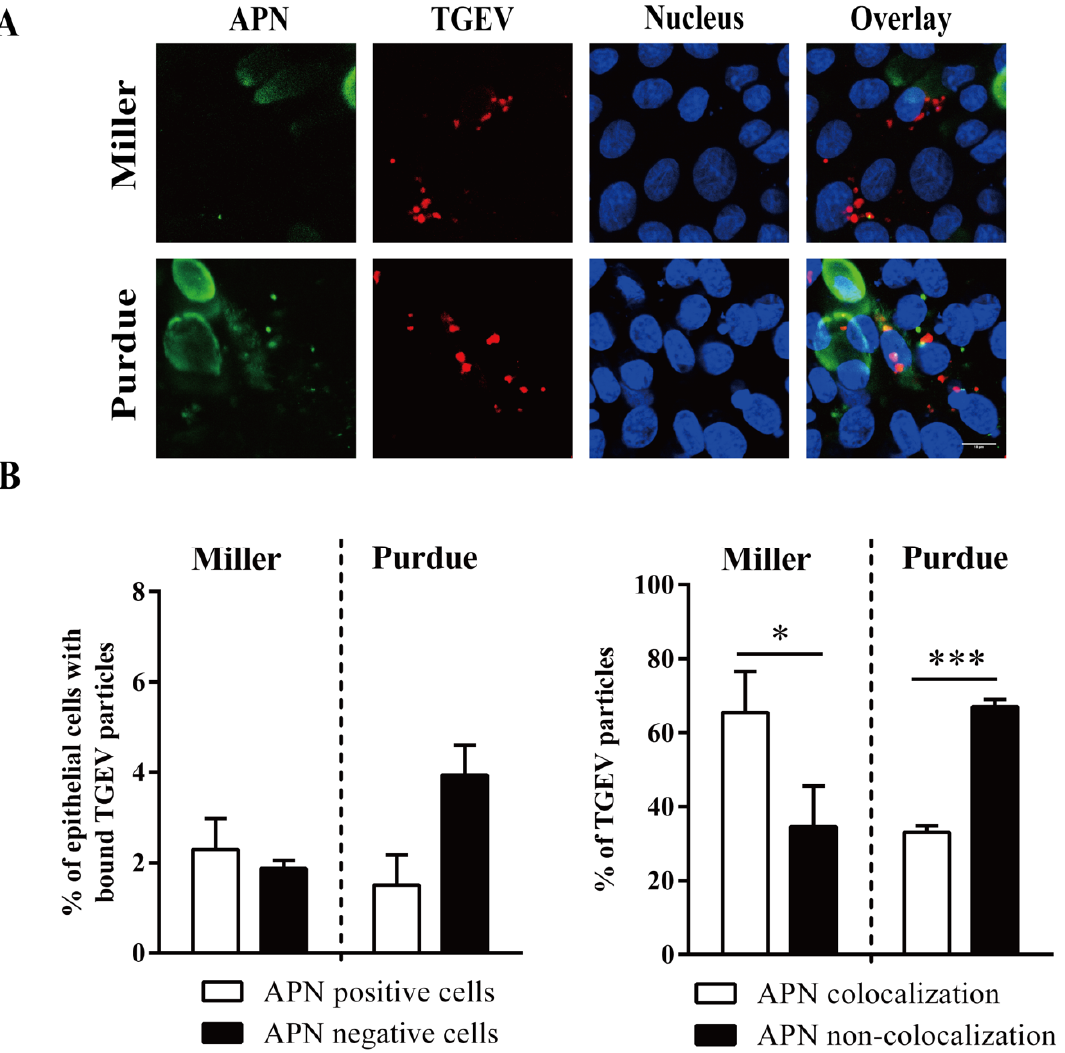
Figure 7. TGEV binds to APN positive/negative enterocytes. Primary enterocytes were inoculated at 4 °C with TGEV particles (m.o.i. = 10). ( A ) Double immunofluorescence staining of TGEV particles bound to APN positive/negative cells. Scale bar: 10 µm. ( B ) The percentage of cells with bound virus particles (left panel). The percentage of APN colocalized TGEV particles was counted based on five random fields (right panel). Data are expressed as the mean ± SD of the results of three separate experiments. Statistically significant differences are indicated as * p < 0.05 and *** p < 0.001. The percentage of SA negative cells with bound TGEV Miller (4.3 ± 0.3%) and with bound TGEV Purdue (5.0 ± 0.9%) was significantly higher than the percentage of SA positive cells with bound TGEV Miller (0.9 ± 0.4%) and with bound TGEV Purdue (2.1 ± 0.3%). The percentage of TGEV Miller particles (29 ± 13%) and TGEV Purdue (32 ± 12%) that colocalized with SA was significantly lower than the particles that did not colocalize, with Miller at 71 ± 13% and Purdue at 68 ± 12% (Figure